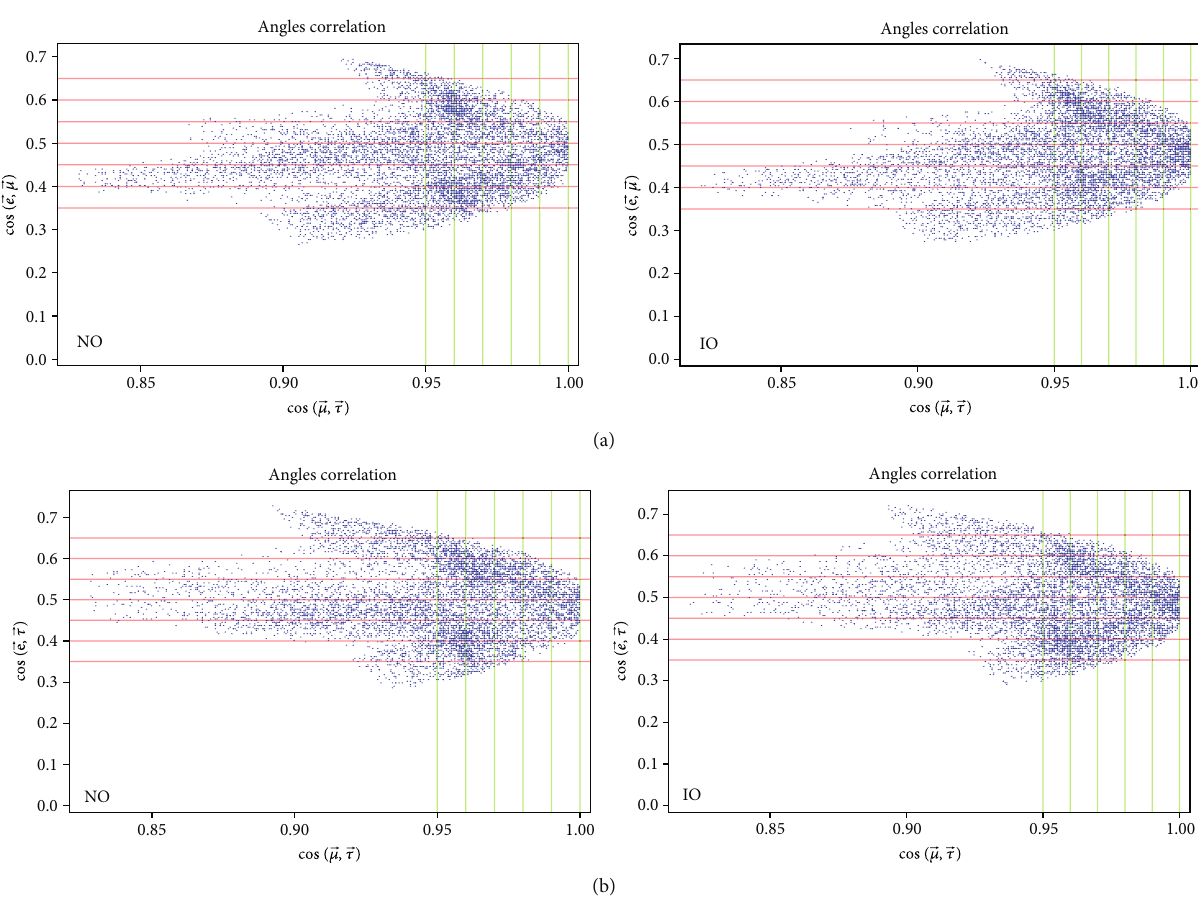
Figure 2: (a) Front view. (b) Top view.